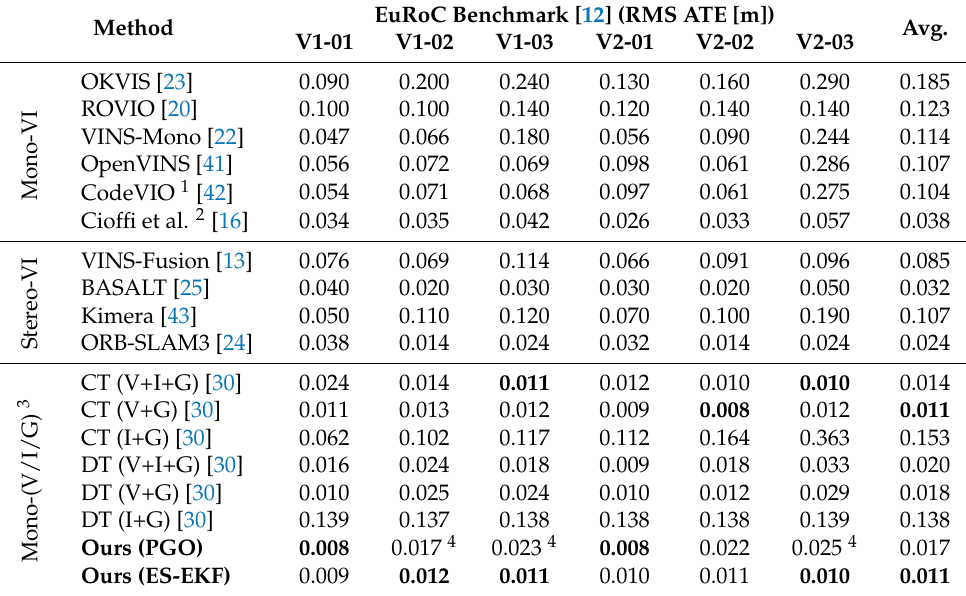
Table 3. Ablation study on the contribution of the GPS sensor on the system accuracy. The latest state-of-the-art (monocular/stereo) VI-SLAM systems are compared to our proposed trajectory initialization (PGO factors) and ES-EKF state estimation methods. Bold denotes the most